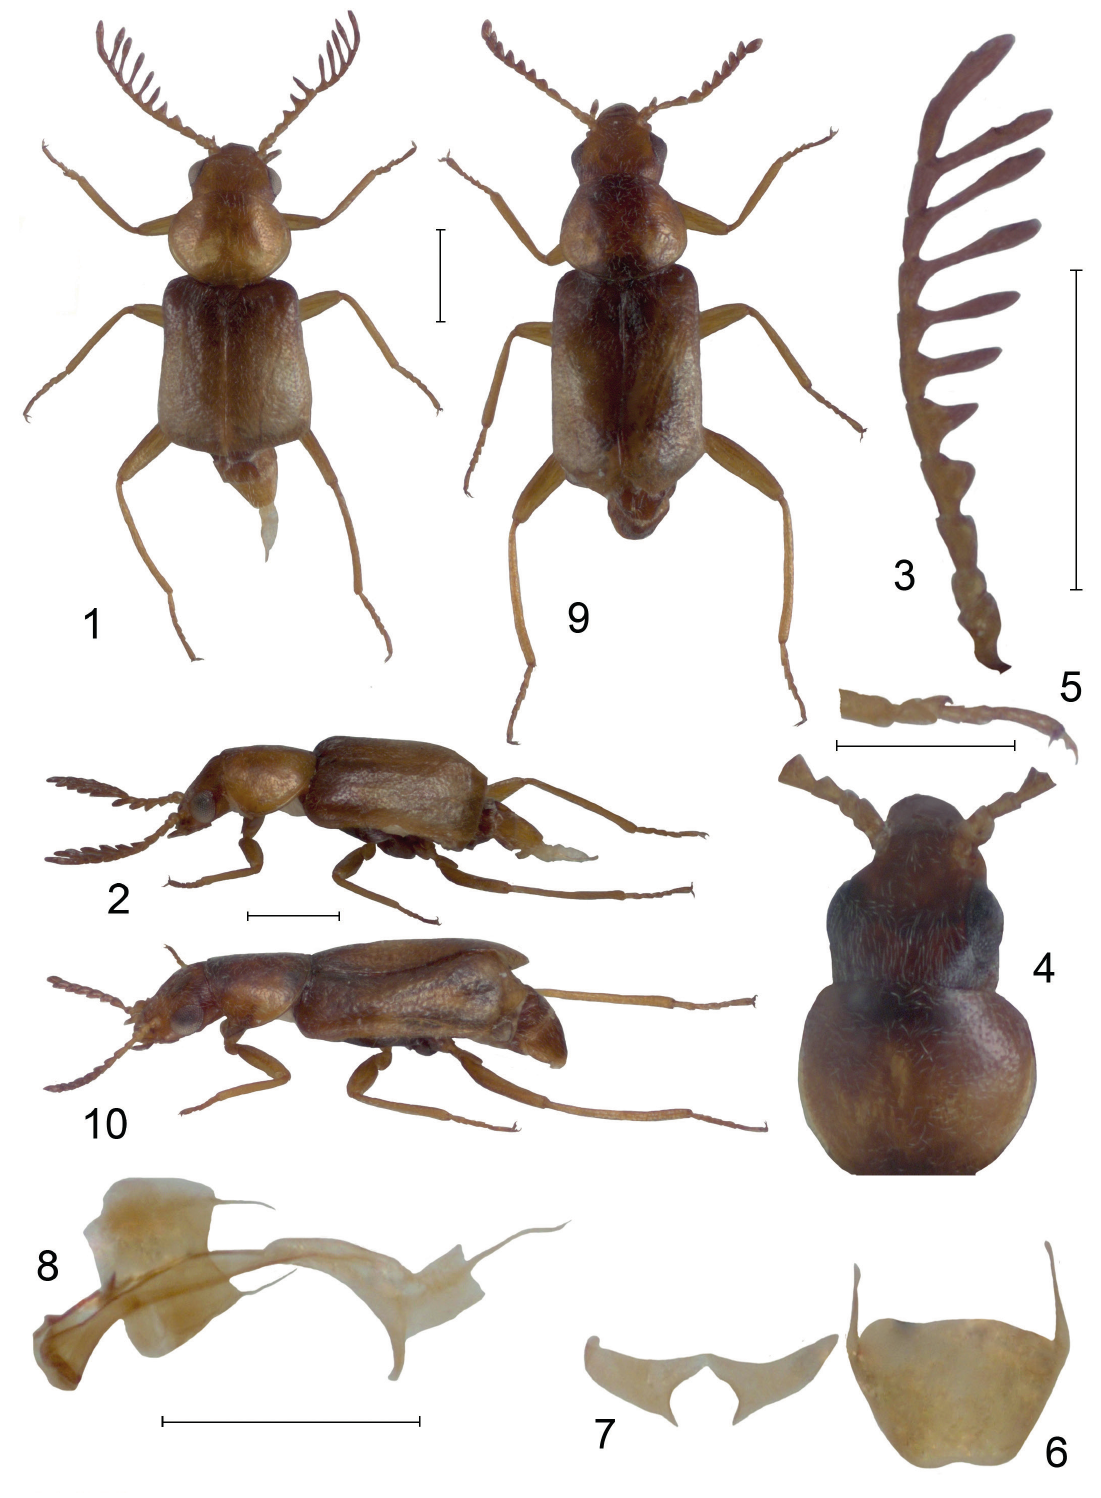
Figs 1–10. Tonyattalus vanharteni gen. et sp. nov., holotype (SCH_ISEA_000133), ♂ (1–8), ♀ (9– 10). 1, 9 . External appearance, dorsal view. 2, 10 . External appearance, lateral view. 3 . Left antenna. 4 . Head and pronotum, dorsal view. 5 . Left anterior tarsus. 6 . Pygidium. 7 . Ultimate abdominal ventrite. 8 . Aedeagus, and tegmen, lateral view. Scale bars: 0.5